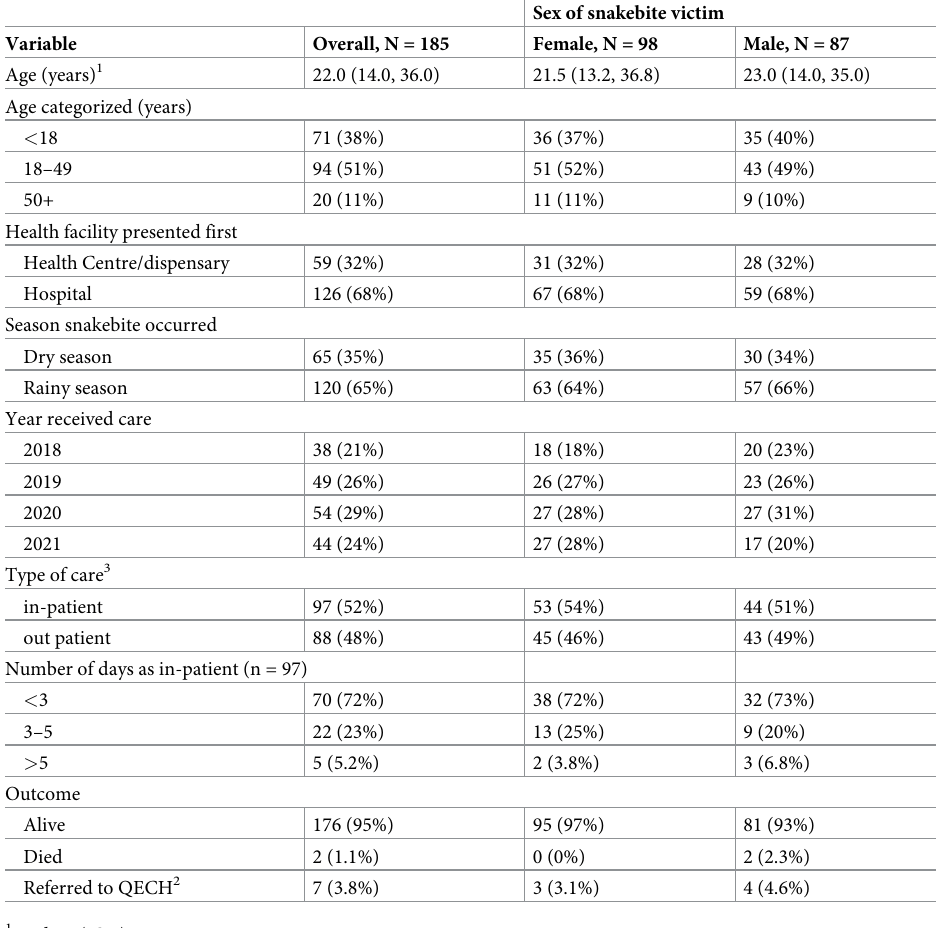
Table 3. Snakebite cases reported to health facilities between Jan. 2018 to Dec.